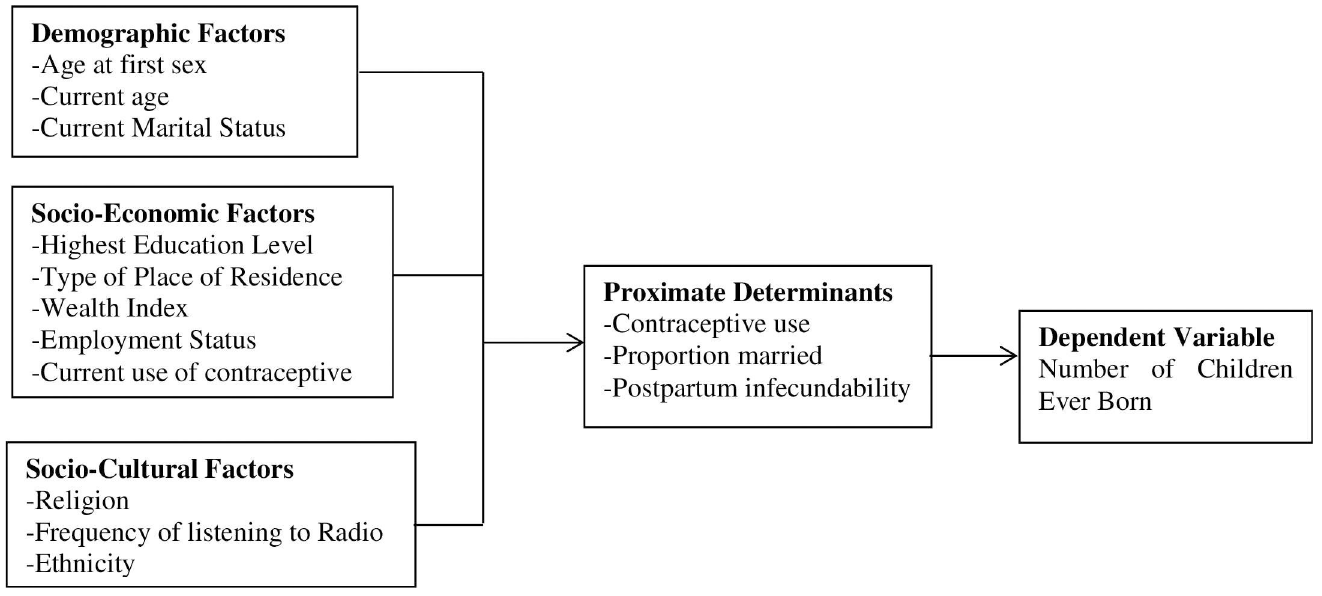
Fig 1. Operational framework.